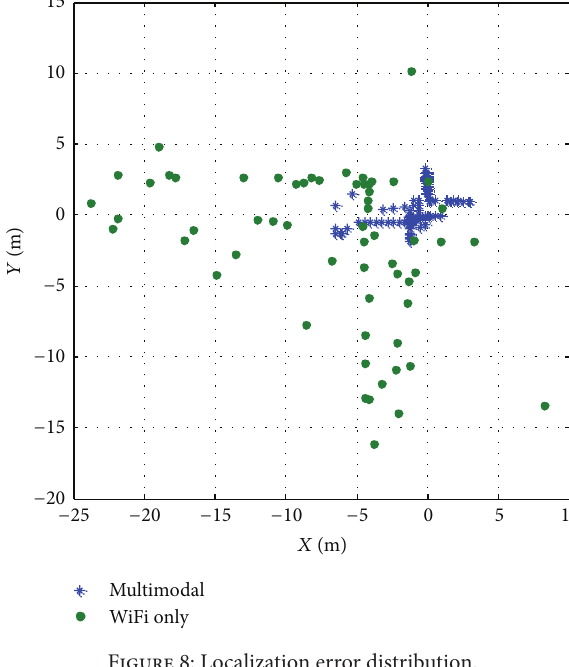
Figure 8: Localization error distribution.